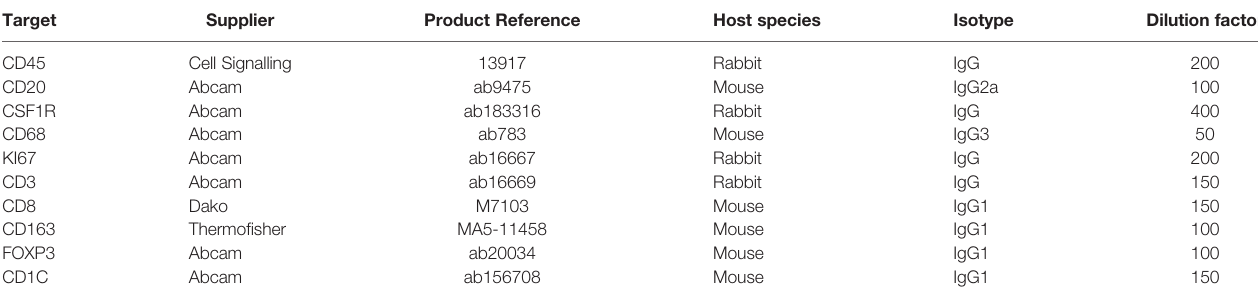
TABLE 1 | Antibodies used in mIHC.